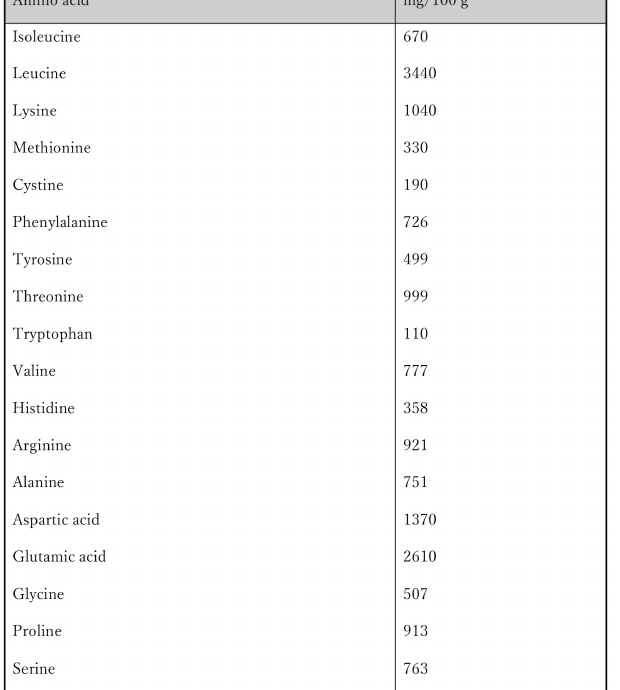
Figure 2. The amino acid analysis of the provided supplemental protein food containing approxi- mately 8 g of amino